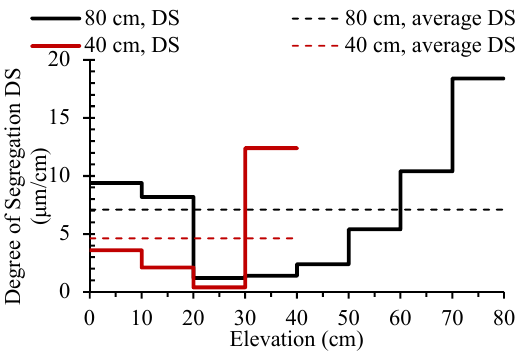
Figure 9. Variation of the degree of segregation ( DS ) along the height of settled backfill for columns of 40 cm and 80 cm, respectively; the elevation was measured from the bottom of the